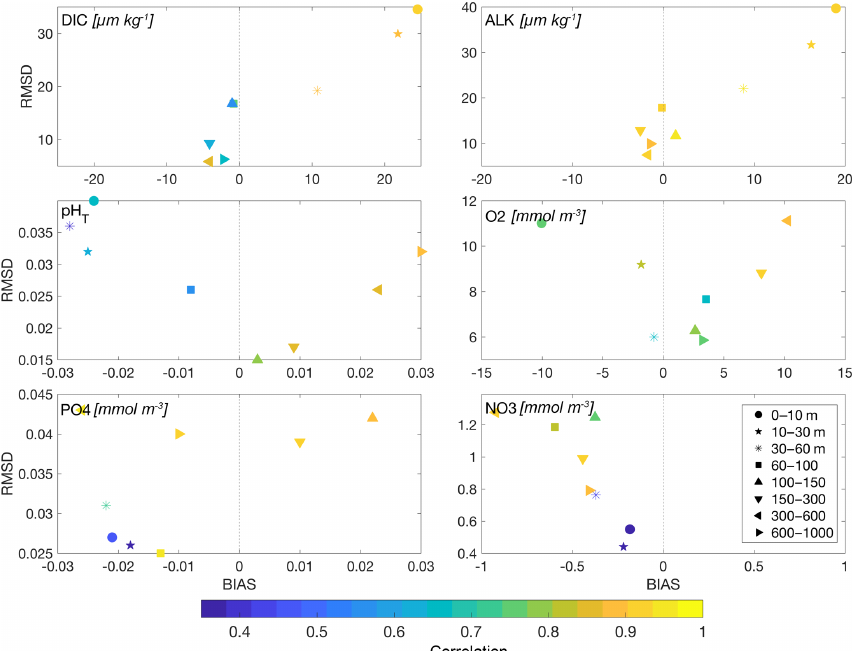
Figure 7. Target diagrams and correlation (values in colour shading) between model and climatology for the different layers (symbols) and for the selected variables: alkalinity (ALK), dissolved inorganic carbon (DIC), oxygen (O 2 ), phosphate (PO 4 ), nitrate (NO 3 ), and pH reported in total scale